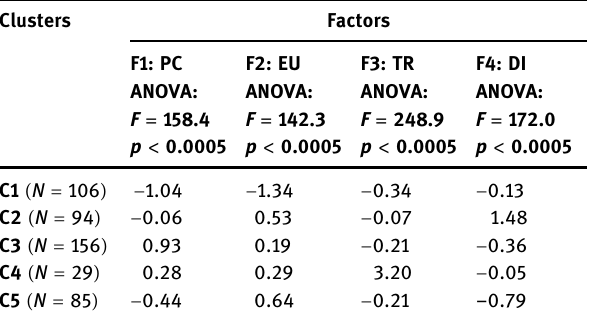
Table 2: Results of k - means CA and cluster centers ( N = 470, 17 missing ) Clusters